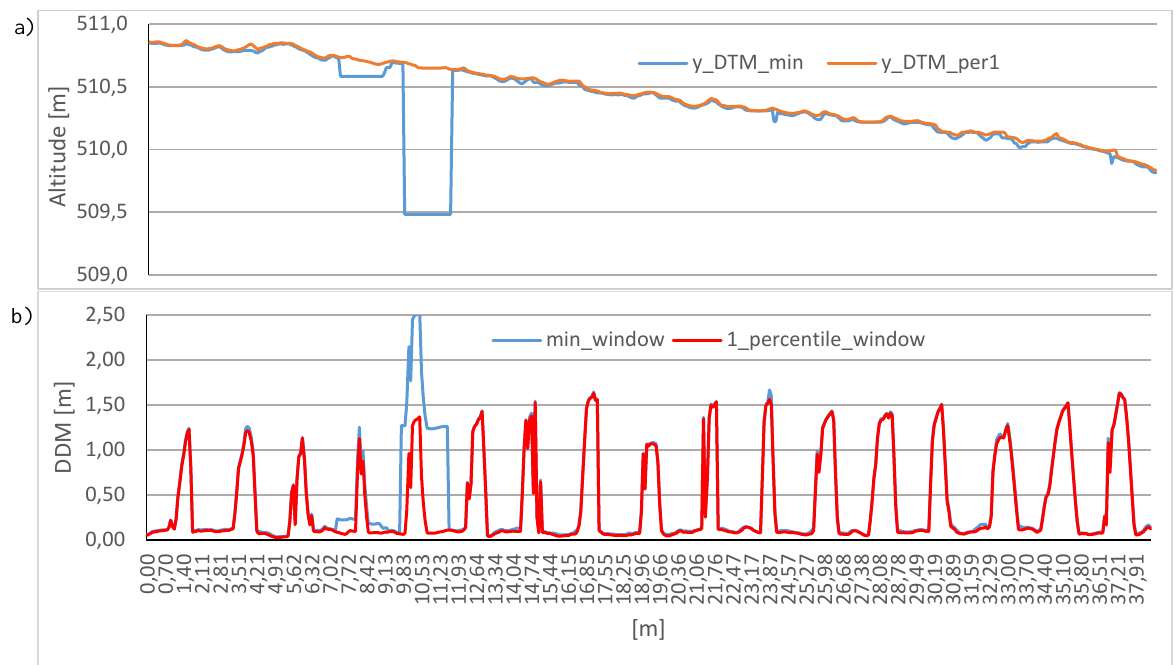
Figure 9 a) Digital Terrain Model reconstructed with minimal value (DTM_min) and 1 percentile value (DTM_per1) b) Digital